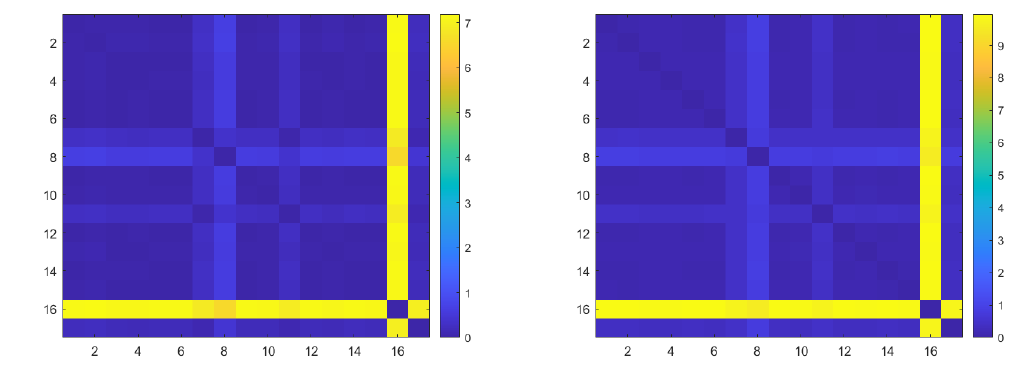
Figure 10. Matrices of distances with scaled colours. On the left is the matrix obtained from PSD, and on the right is the matrix obtained from the